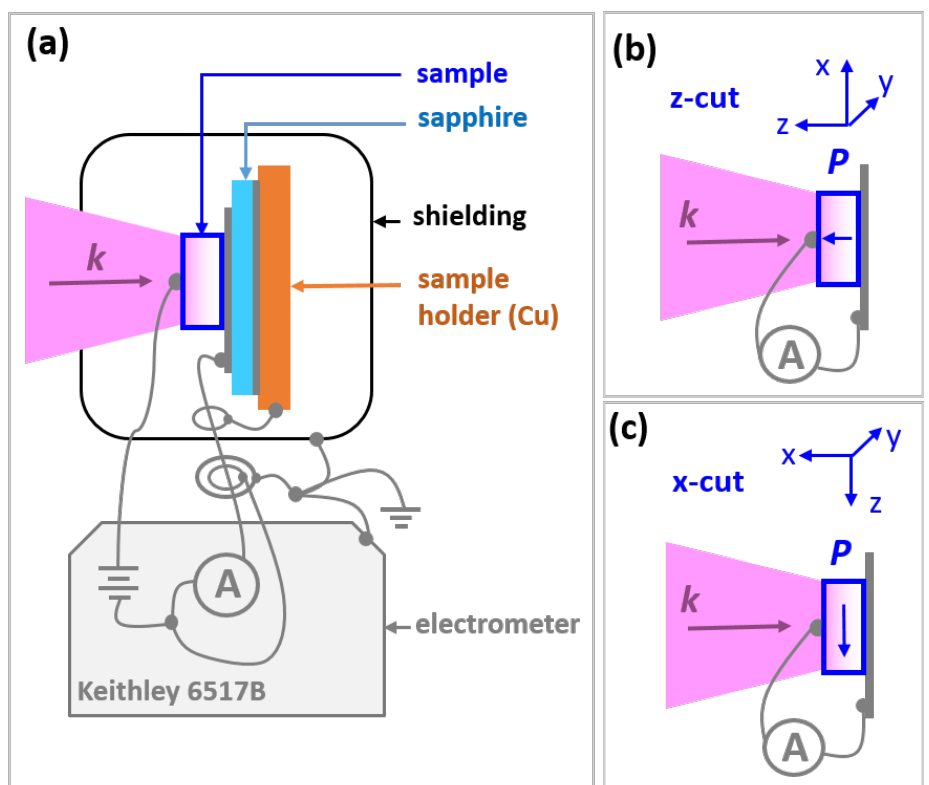
Figure 1. ( a ) Scheme of the electrical measurement configuration. For the realization of the optical beam path between white-light source and final focus on the sample see ref. [31]. Panels ( b , c ) illustrate the light incidence (wave vector k ) towards the z- and x-cut SBN crystal, respectively, with blue arrows indicating the axis of (ferro-)electric polarization (vector P ) in the sample, which is in this case equal to the optical axis. The blue coordinate systems refer to the crystal axes. Note that the electric-field vector E of the unpolarized light is perpendicular to the optical/polar axis z of the crystal in case ( b )/z-cut and lies in the yz plane of the crystal in case ( c